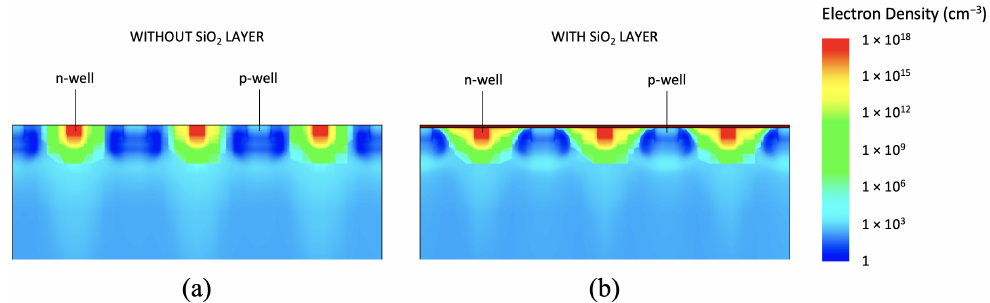
Figure 15. Electron density in an example microstrip simulation domain without ( a ) and with ( b ) the SiO 2 layer on top of the